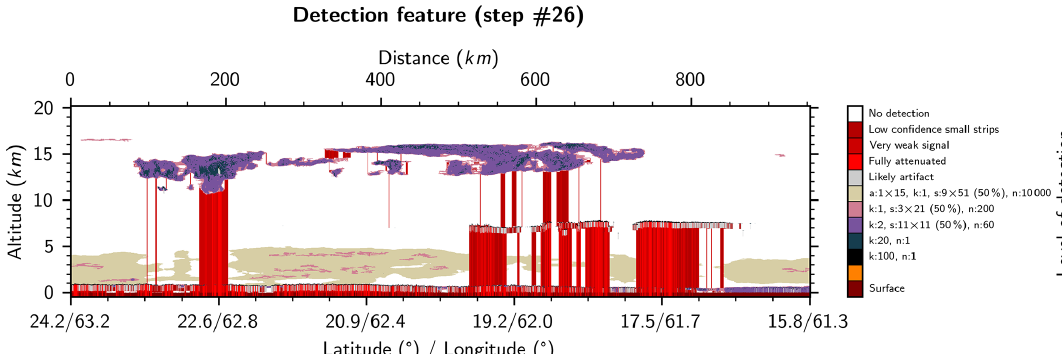
Figure 7. Final feature mask of the 532nm parallel